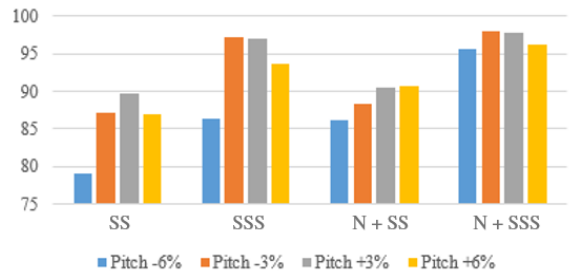
Figure 5. Results for synthetic datasets, Set 1 Pitch modifications.